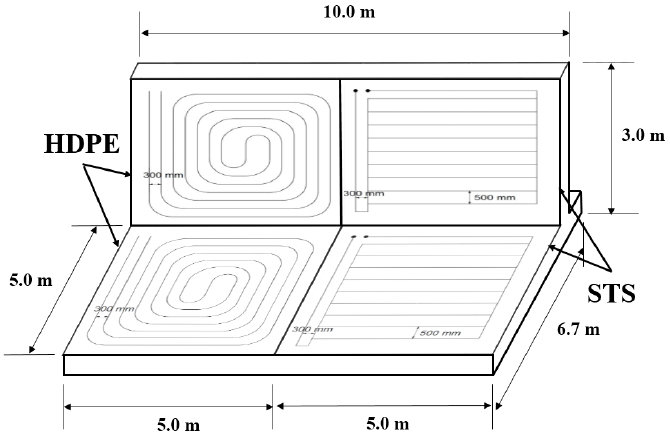
Table 1. Length and thermal conductivity of each heat exchange pipe.